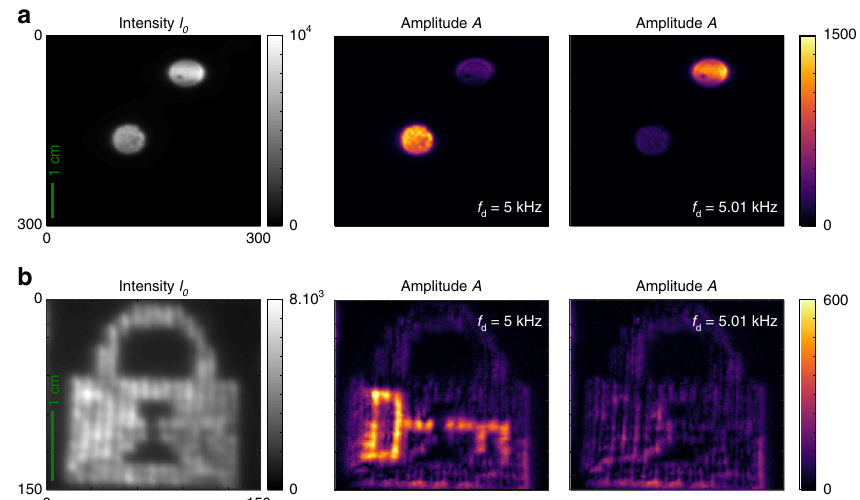
Fig. 4 Experimental illustration of potential applications of FAST-QUAD. a Demonstration of frequency tuning: two laser spots of equal intensity and equal modulation index, but of distinct modulation frequencies (respectively 5.00 kHz and 5.01 kHz) are imaged and demodulated with FAST-QUAD (exposure time 2 s). Left: Estimated average intensity map when demodulation frequency is set to f amplitude maps demonstrate that FAST-QUAD can be continuously tuned to any demodulation frequency, making it possible to actively select and discriminate emitters at different frequencies. b Demonstration of image encryption with modulated light: an intensity-modulated object (key) is concealed in an unmodulated background (lock), and the scene is imaged with FAST-QUAD (exposure time 1 s). Left: The encrypted image cannot be detected on a conventional intensity camera. Right: Modulation amplitude maps demonstrate that FAST-QUAD can retrieve the concealed image when f exact frequency used by the sender.